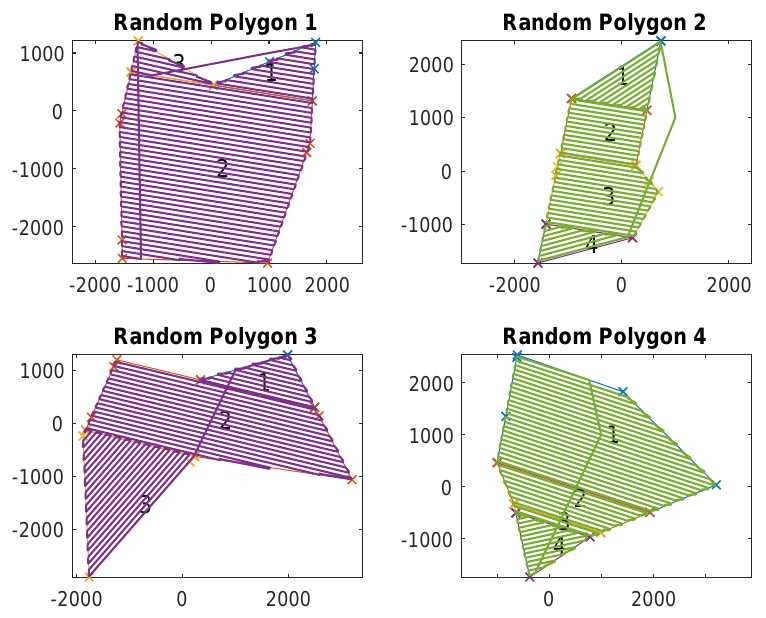
Figure 24. A sample of randomly generated polygons, their optimal decomposition and the associated FTIW path used in the Monte Carlo